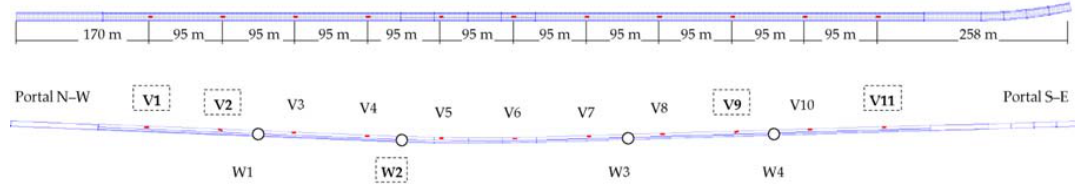
Figure 1. The overall sketch of the tunnel.